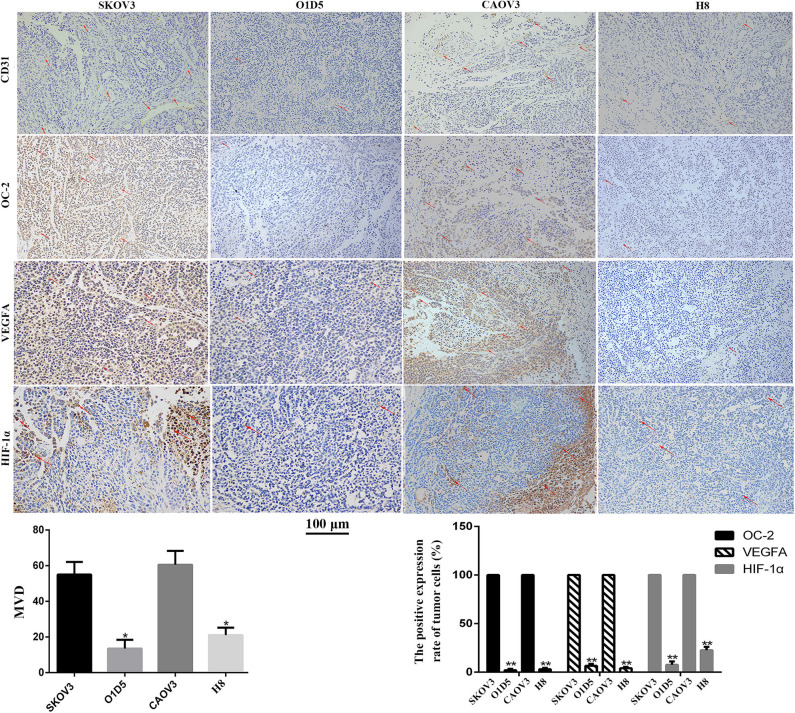
OC-2 KO inhibited the tumor angiogenesis in the xenograft model of SKOV3 and CAOV3 cells. IHC staining was performed to analyze the expression levels of CD31, OC-2, VEGFA, and HIF-1α in tumor sections. The positive spots were indicated by red arrows and calculated by ImageJ software in five random fields. Up panel, representative images. Down panel, statistical analysis of positive expression data. Scale bars, 100 μm. *P < 0.05, **P < 0.01.